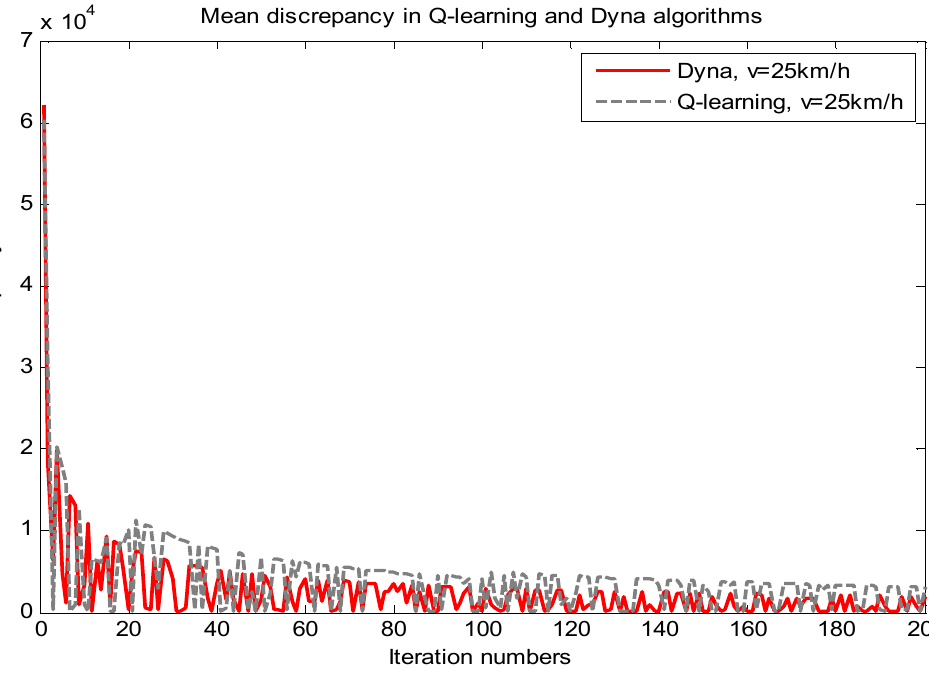
Figure 10. Mean discrepancy of the value function in the Q -learning and Dyna